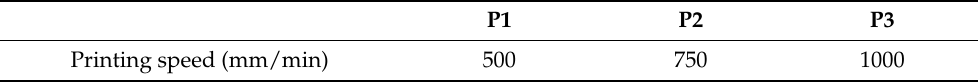
Table 2. Printing speeds for different simulation